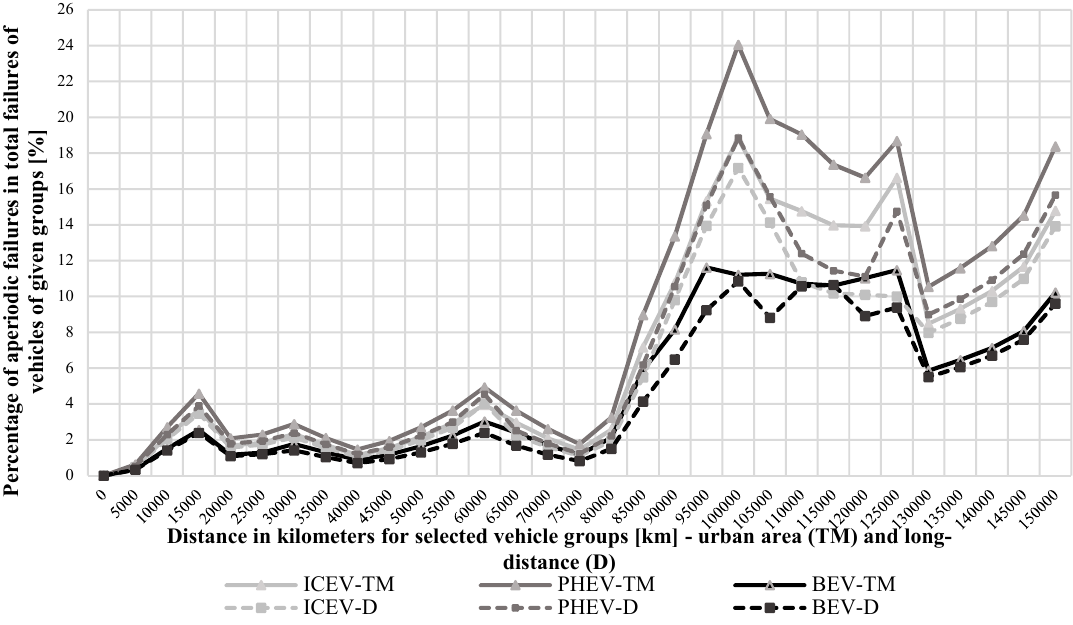
Figure 12. Distribution of aperiodic failures for a 4x4 vehicle with ICEV, PHEV, and BEV propulsion for urban and long-distance speed profiles over a distance of 150,000 km.